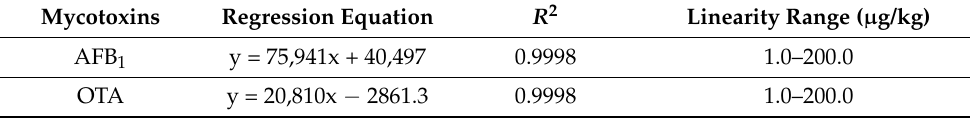
Table 5. HPLC regression equation, correlation coefficient, and linear range ( µ g/kg).